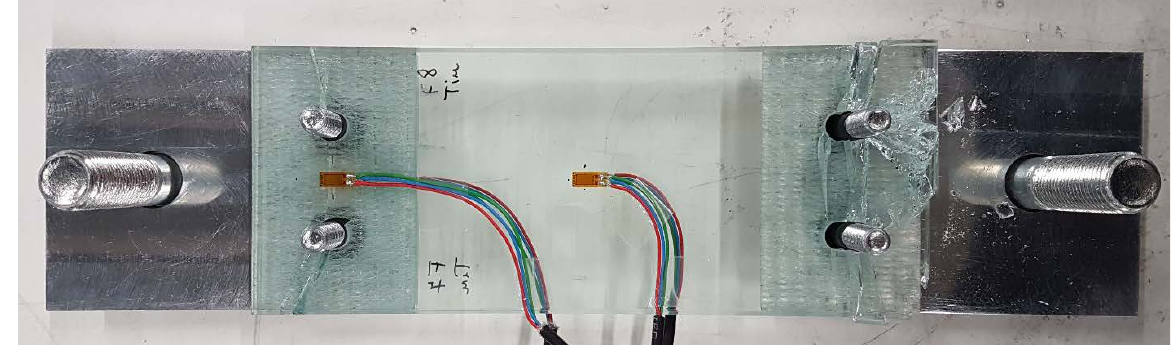
Fig. 6 Failure pattern of a reinforced annealed glass test specimen